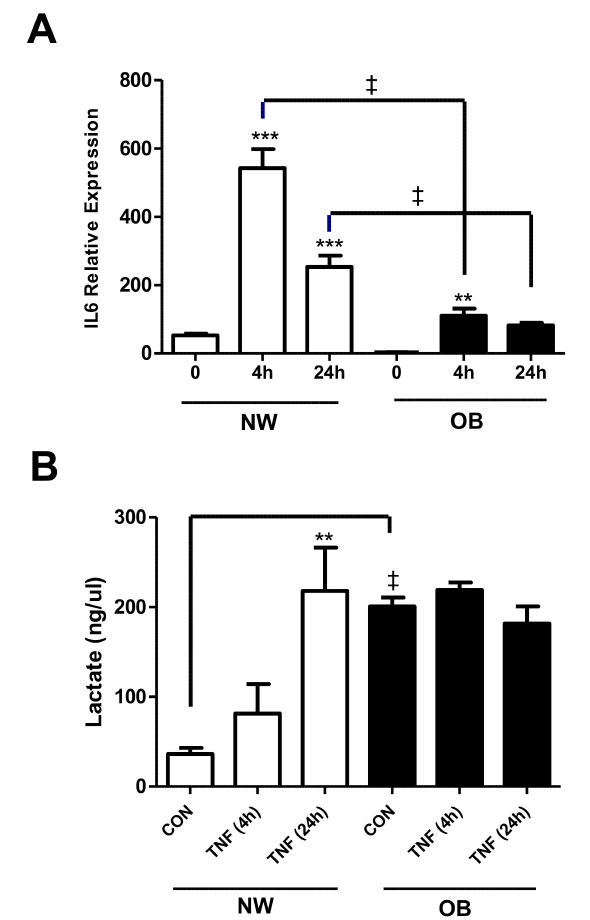
Figure 2. Lactate secretion is greater in obese OA synovial fibroblasts and is induced during the inflammatory response. The effect of TNF α (10 ng/mL) stimulation of synovial fibroblasts from normal-weight (NW) or obese OA patients (n = 3) on ( A ) the expression of IL-6 and ( B ) secretion of lactate after 4 h and 24 h stimulation. Data expressed as mean ± SEM. ** = p < 0.01, *** = p < 0.001, significantly different from time 0. ‡ = p < 0.01, significantly different between synovial fibroblasts from patients with different